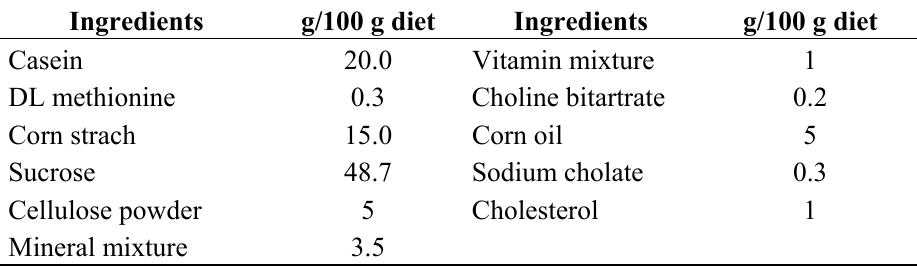
Table 1. Composition of the Piagen diet